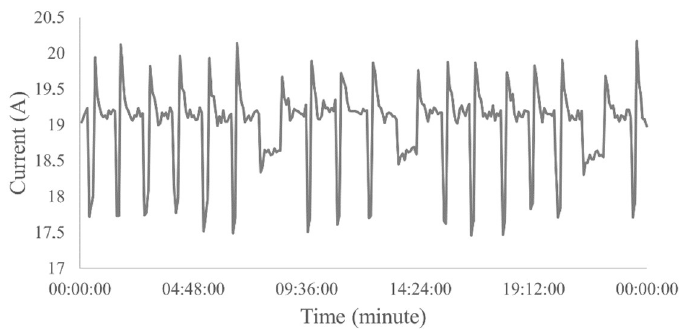
Figure 6. Example of a real well operating with gas for 24 h.